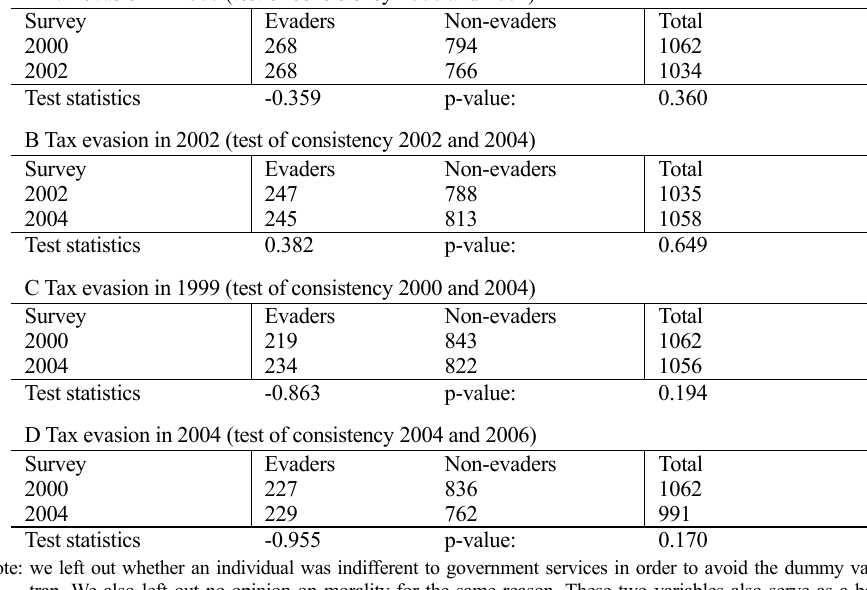
Table A.1 : Tests of Consistency of Surveys: Comparison of Retrospective Estimates of Evasion, Czech